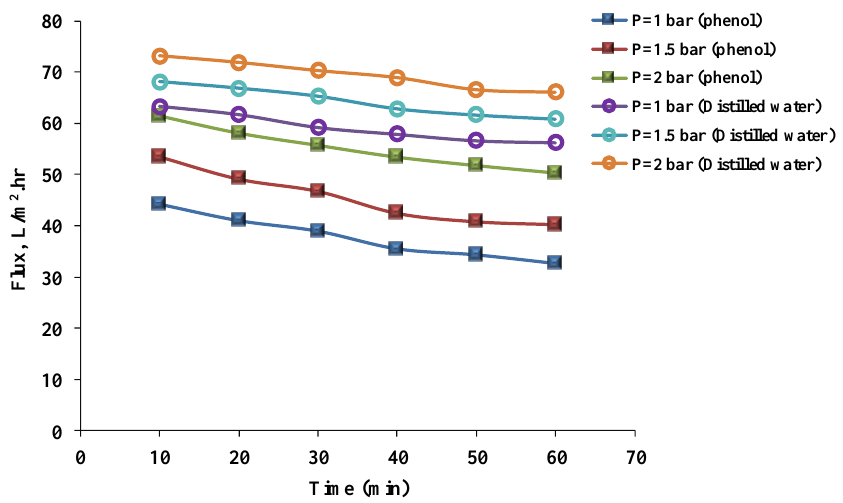
Figure 5. The phenol solution and distilled water’s fluxes with time for a hydrophilic membrane at different pressures (phenol concentration = 50 mg/L, temperature = 30 °C).